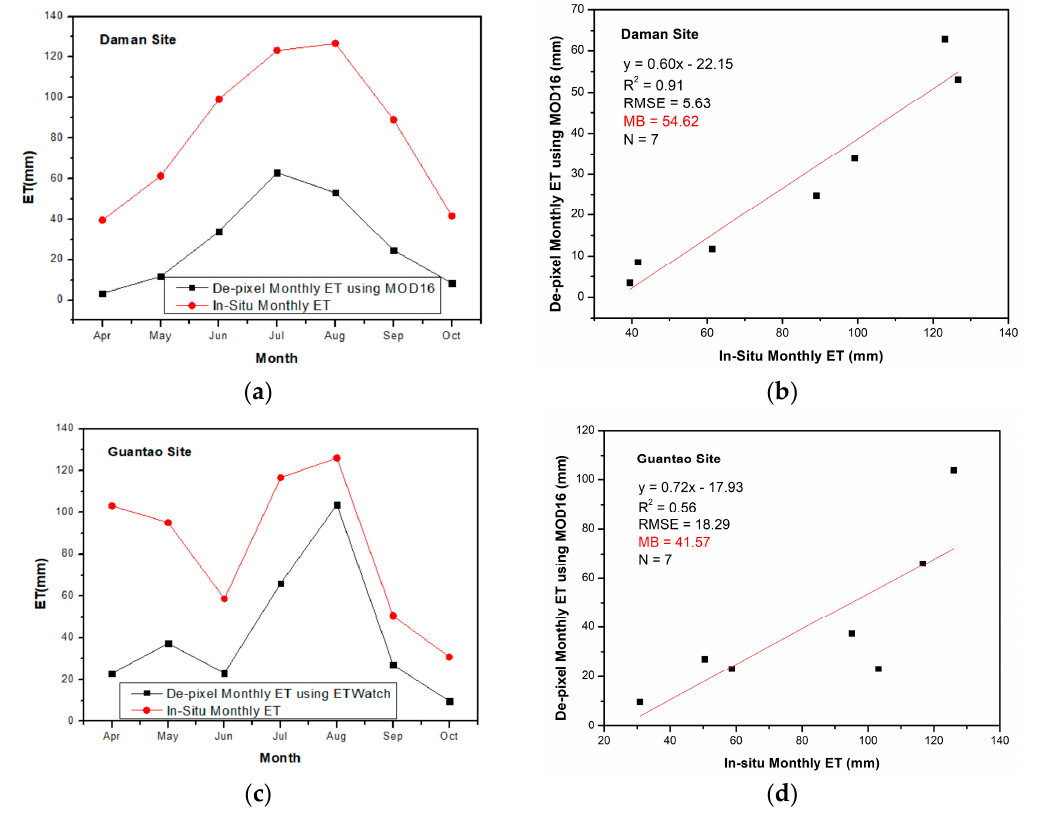
Figure 8. Comparisons of downscaled 30-m ET data from the MOD16 with in situ observations at the Daman Site ( a , b ) and the Guantao site ( c , d ).